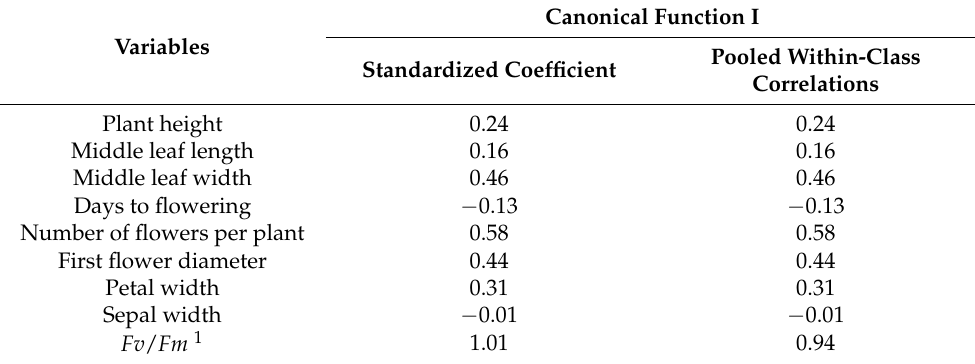
Table 2. The flower characteristics and the growth trait variables associated with NaCl treatment (8 dS m − 1 ) as determined by canonical discriminant analysis, standardized canonical coefficients, and pooled within-class correlations with the first canonical